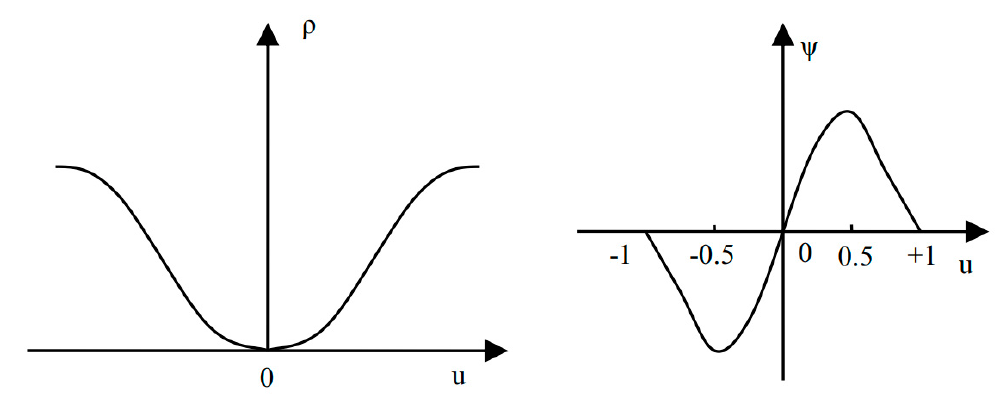
Figure 8. The 𝜌, 𝜑 functions of Tukey. Figure 8. The ρ , ϕ functions of Tukey.